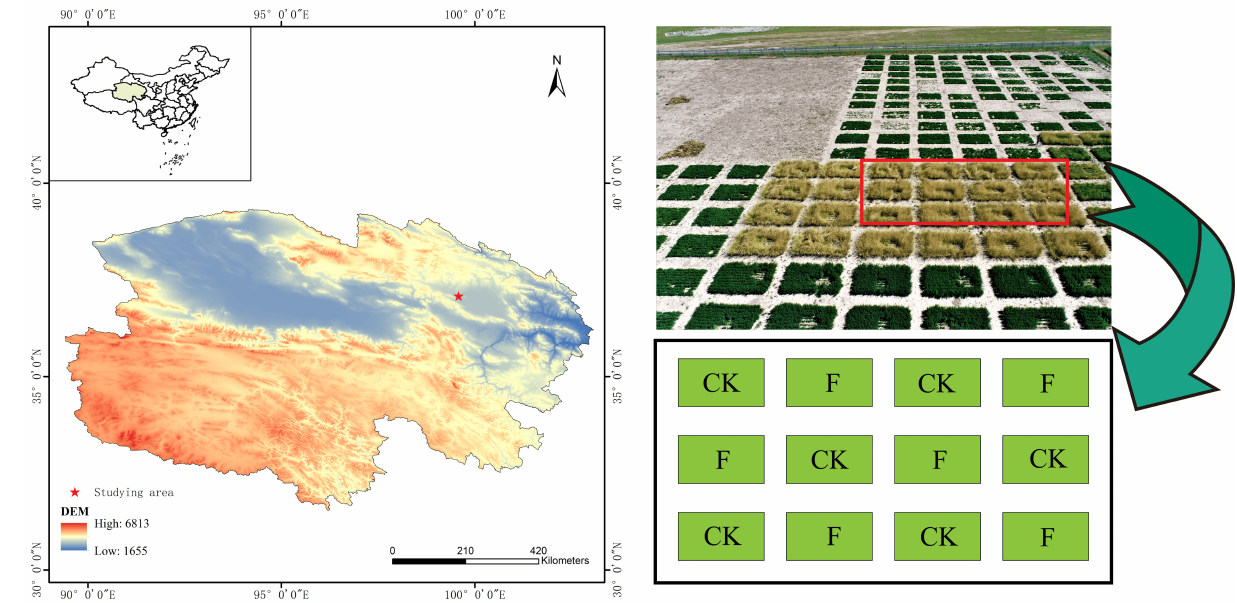
Figure 1. Distribution of sampling plots in the study